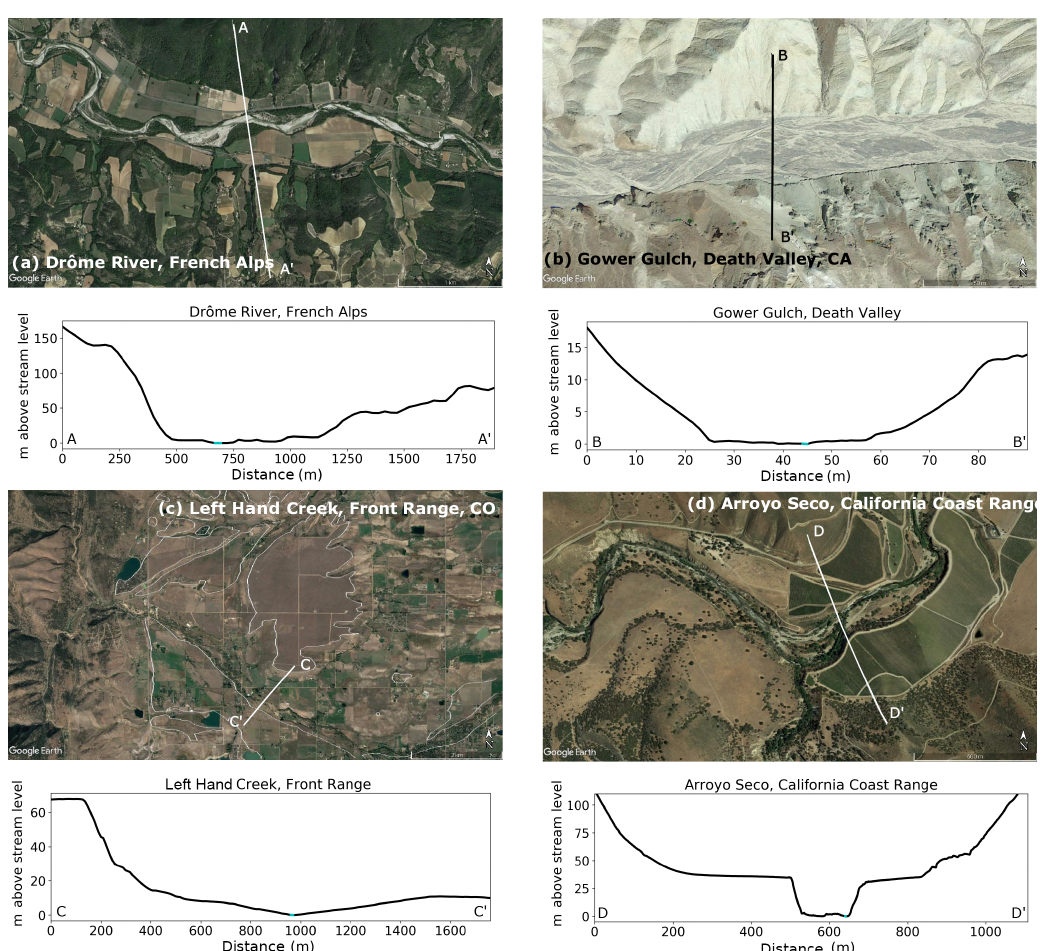
Figure 1. Field examples of wide bedrock valleys cut by lateral erosion. All cross sections are from north to south. (a) The Drôme River in the French Alps is transport limited and meandering in reaches that carve wide bedrock valleys. The bedrock valley at this location (44.69 ◦ N, 5.14 ◦ E) is 500m wide and the channel is ∼ 45m wide (indicated by light blue shade of cross section line). (b) Gower Gulch (36.41 ◦ N, 116.83 ◦ W) in Death Valley, USA widened significantly in response to increased discharge from a stream diversion in the 1940s (Snyder and Kammer, 2008). The bedrock valley is 30m wide and the channel braids are ∼ 2m wide (indicated by light blue shade of cross section line). (c) Left Hand Creek drains the Colorado Front Range (40.11 ◦ N, 105.25 ◦ W) and has undergone multiple cycles of lateral erosion that produced flights of strath terraces, outlined in white on the image. The cross section shows Table Mountain at ∼ 70m above the current stream height on the north side of cross section and a lower terrace level at 10m above the current stream level on the south side of the cross section. (d) Arroyo Seco in the California Coast Range (36.27 ◦ N, 121.33 ◦ W) carved a 600m wide strath terrace during a period of lateral erosion that is 30m above the current stream level. The current bedrock valley is 125m wide and the channel is ∼ 15m wide (indicated by light blue shade of cross section line). Images: Google Earth. Cross sections: NCALM and 30m